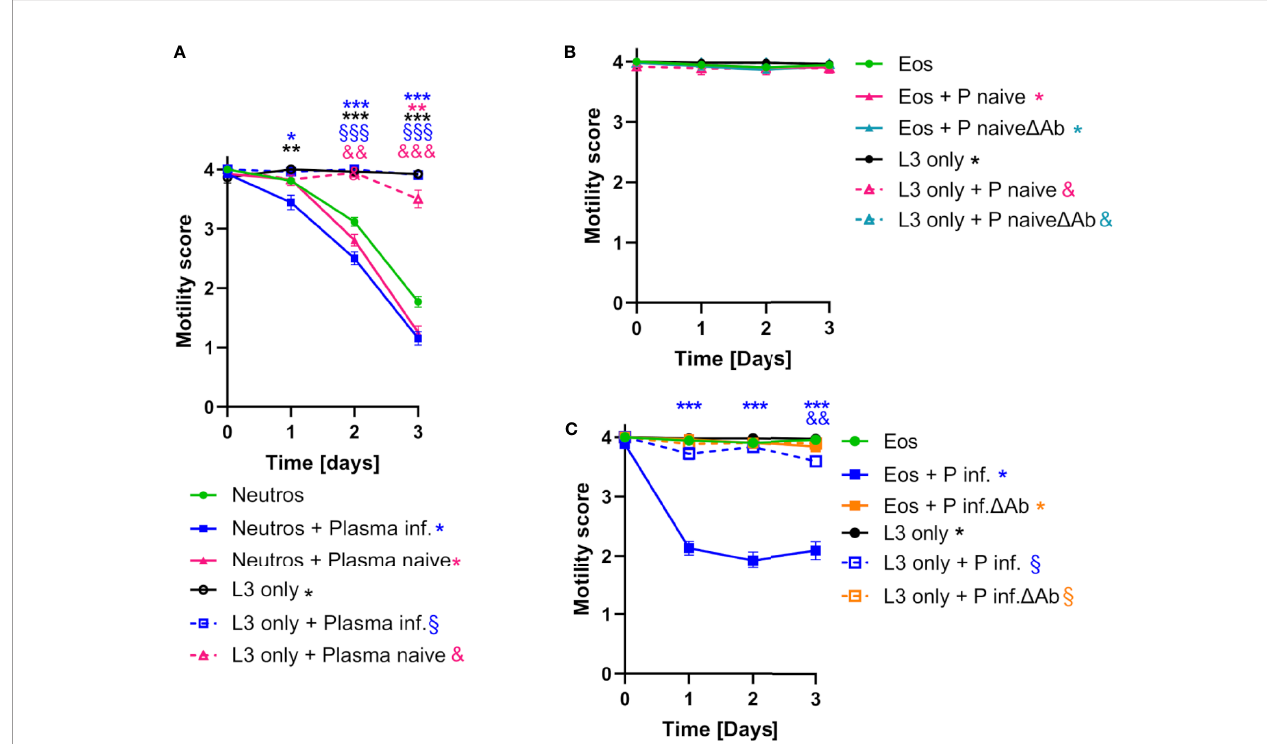
FIGURE 3 | Neutrophils and eosinophils reduce S. ratti L3 motility in vitro. (A) L3 larval motility score of S. ratti L3 co-cultured with neutrophils in the absence ( (cid:129) ) or presence of plasma from infected ( ▪ ) or naive ( ▲ ) animals or L3 cultured alone in the absence (L3 only: (cid:129) ) or presence of plasma (infected: □ , naive: D ). Shown are mean with SEM with n=52 per time point and group, of one experiment representative for two independent repeats. Asterisks, § and & show statistical signi fi cance calculated by 2-way ANOVA with Bonferroni ’ s post-hoc test comparing neutrophils with neutrophils + Plasma infected (*), neutrophils + Plasma naive (*), L3 only (*), L3 only + Plasma infected (§) or L3 only + Plasma naive (&). p < 0.05 *, p < 0.01 ** / &&, p < 0.001 *** / &&& / §§§. (B, C) L3 motility score co-cultured with eosinophils in the absence ( (cid:129) ) or presence of plasma derived from infected or naive animals with (infected: ▪ , naive: ▲ ) or without antibodies ( D Ab) (infected: ▪ , naive: ▲ ) or L3 culture alone in the absence (L3 only: (cid:129) ) or presence of plasma (infected: □ ;, naive: D , infected D Ab: □ , naïve D Ab: D ). Shown is mean with SEM with n=52 per time point and group, data are representative for one out of two independent experiments. Asterisk, § and & show statistical signi fi cance calculated by 2-way ANOVA with Bonferroni ’ s post-hoc test comparing eosinophils with eosinophils + Plasma infected (*), eosinophils + Plasma naive (*), eosinophils + Plasma naive D Ab (*), eosinophils + Plasma infected D Ab (*), L3 only (*), L3 only + Plasma infected (§) or L3 only + Plasma naive (&), L3 only + Plasma naive D ab (&), L3 only + Plasma infected D Ab (§). p < 0.01 && p < 0.001 ***. S. ratti larval opsonization by immune plasma in vitro was determined by fl uorescence microscopy and is shown in Supplementary Figure S5